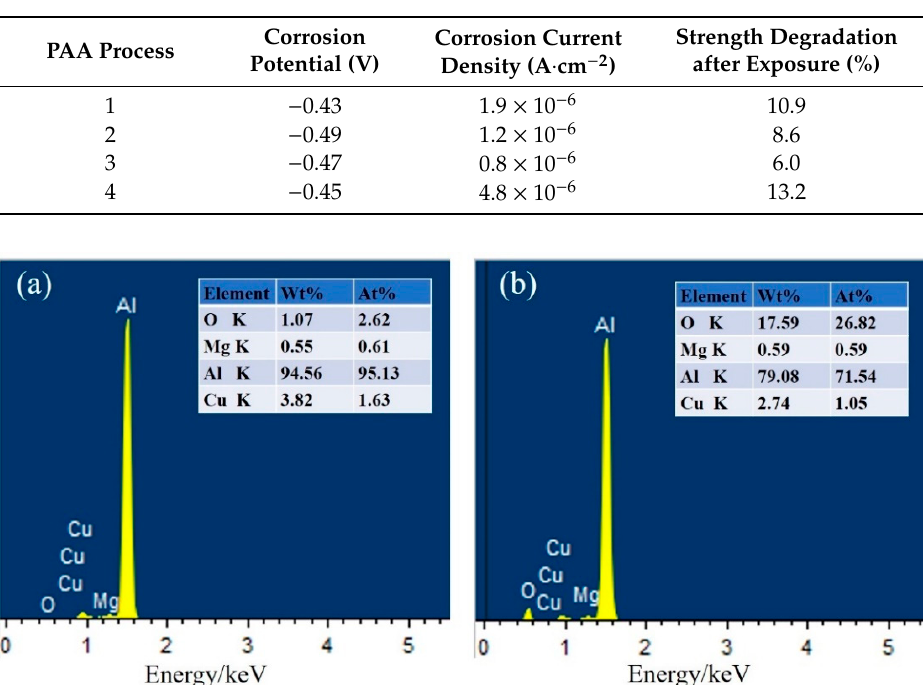
Table 6. Effect of surface roughness on corrosion resistant and durability. Table 6. E ff ect of surface roughness on corrosion resistant and durability.